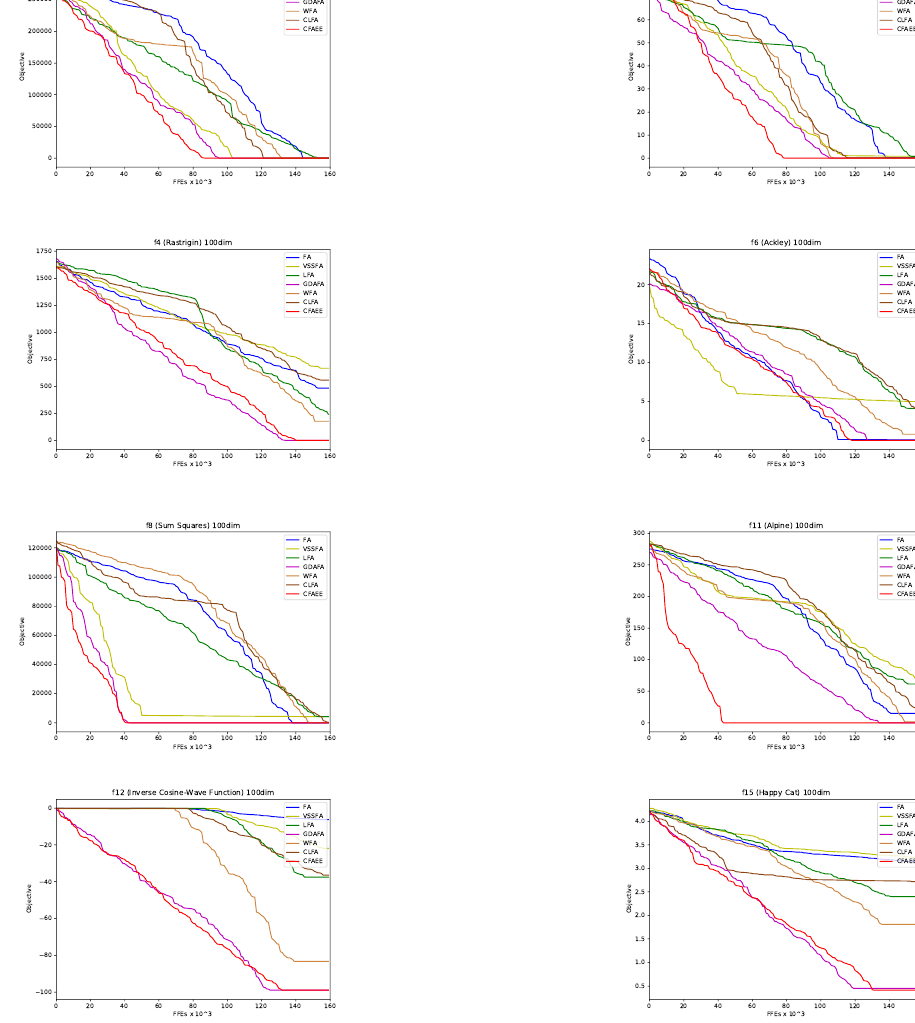
Figure 1. Mean convergence speed graphs for some benchmark instances (Benchmark set